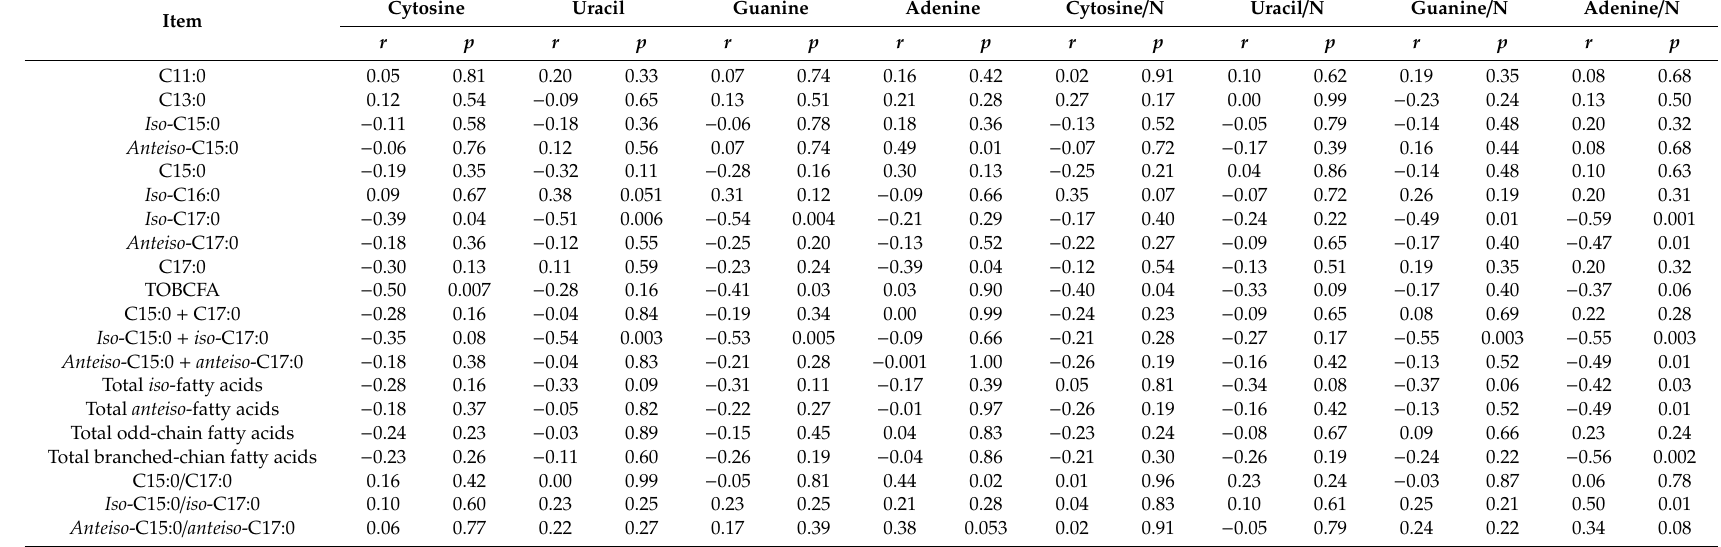
Table 8. Correlation between microbial protein marked by nucleic acids, marker:N ratio in rumen (when using nucleic acids as the microbial marker), and milk OBCFA pattern ( n =